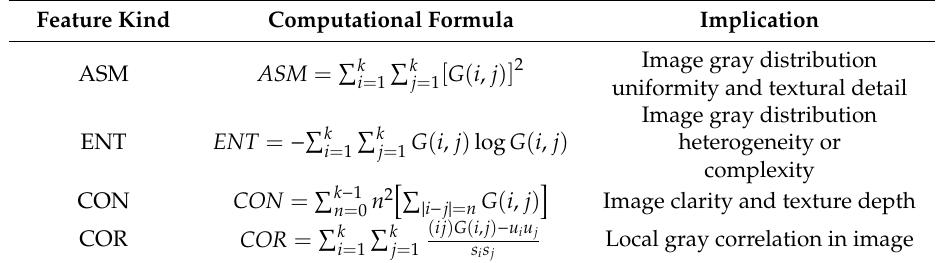
Table 2. Implication of texture features extracted from the gray-level co-occurrence matrix (GLCM). Types of features are angular second moment (ASM), entropy (ENT), contrast (CON), and correlation